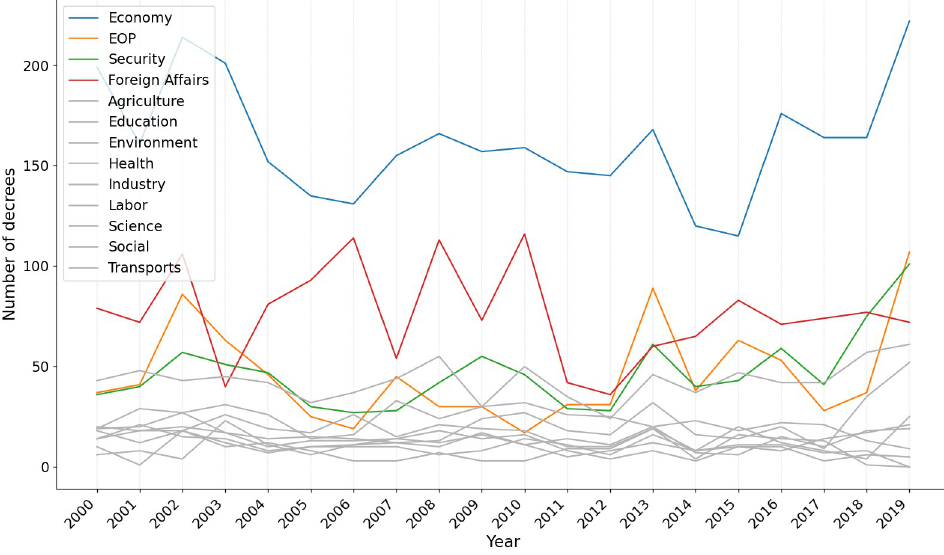
Fig 10. Number of decrees per year from the perspective of the cabinets-based taxonomy focusing on the top 4 areas most issued in